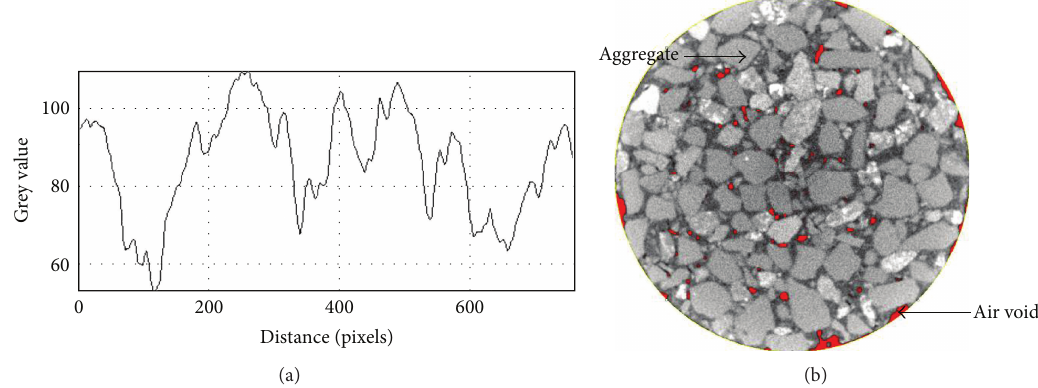
Figure 4: (a) Plot of grey value profile in asphalt mixture; (b) threshold image showing air voids in compacted asphalt mixture.